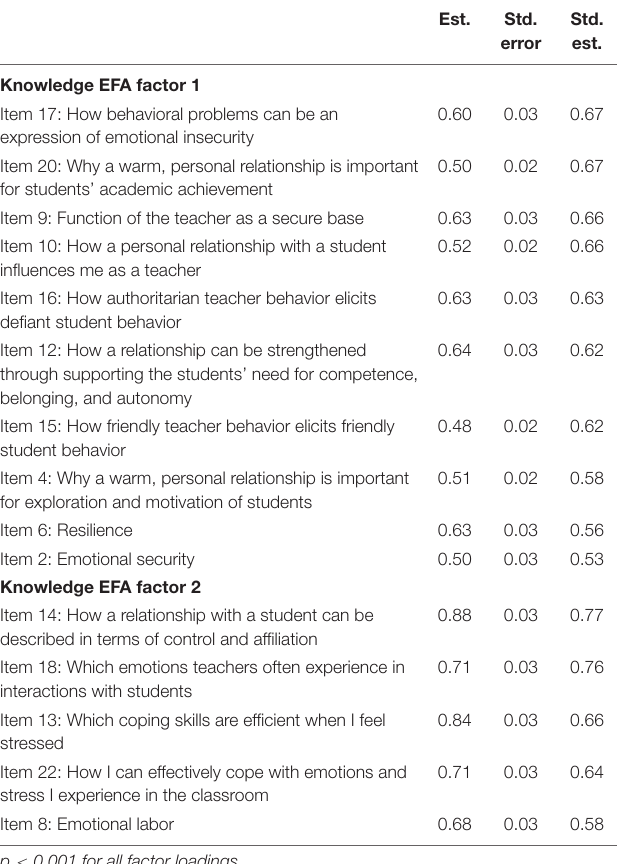
Est. Std. Std. error